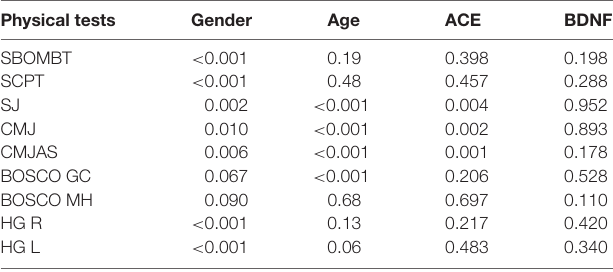
TABLE 3 | The effect ( p -value) of gender, age, angiotensin-converting enzyme (ACE), and brain-derived neurotrophic factor (BNDF) in each physical test. Physical